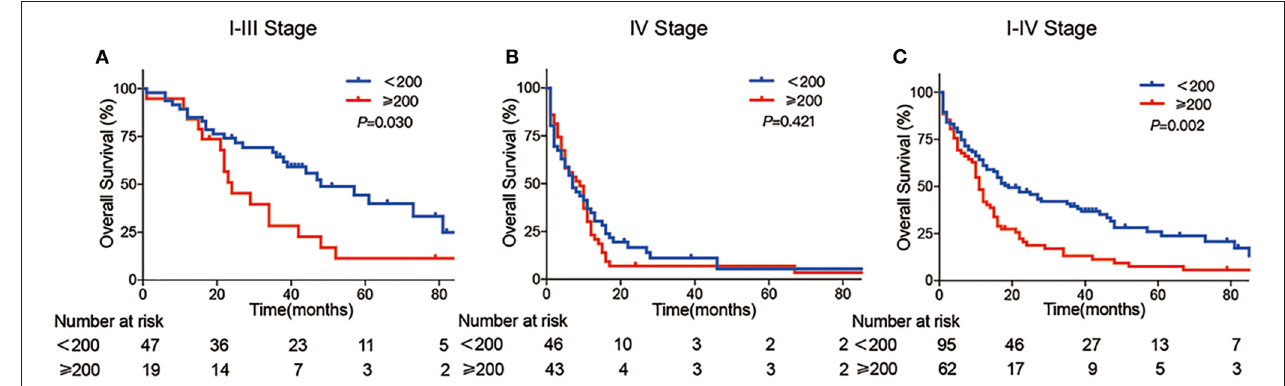
FIGURE 3 | Kaplan–Meier curve of APA-GI compared by AFP level. Comparison of survival between APA-GI patients with AFP ≥ 200ng/ml and AFP < 200ng/ml: (A) compare between stages I–III patients; (B) compare between stage IV patients; (C) compare between stages I–IV patients. Notably, two patients were unable to perform accurate staging due to the lack of medical imaging data. Therefore, they can only be classified as stages I–IV. IRS 0–1, 2–3, 4–8, and 9–12 was referred to negative, week positive, moderate positive and strong positive,